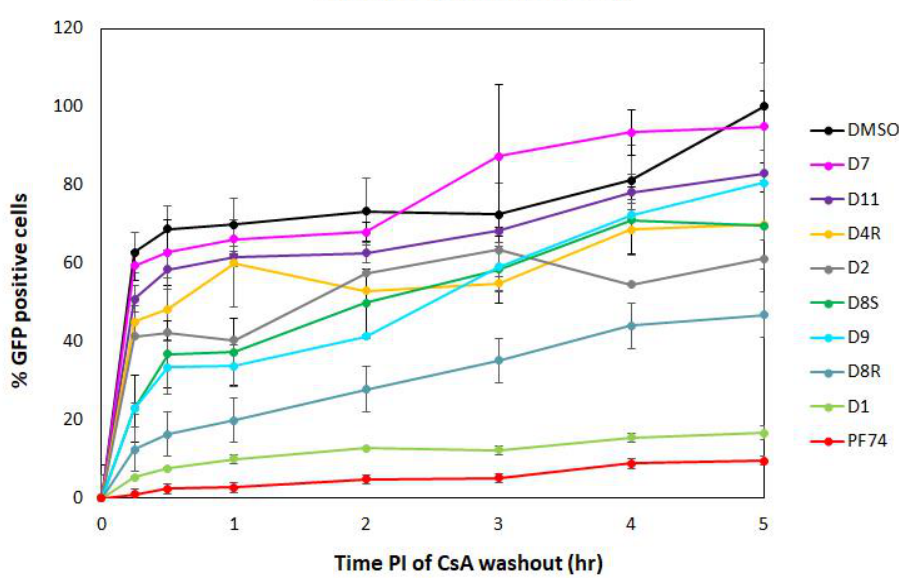
Figure 4. CsA-washout assay. Owl monkey kidney (OMK) cells were infected by spinoculation with an ELISA-normalized amount of VSV-G pseudotyped HIV-1 in the presence of CsA and DMSO, PF74 and its derivatives. Inhibitors were added to the HIV-1 sample before spinoculation at a final concentration of 10 µ M. At the indicated times post-infection, the CsA-containing medium was replaced with fresh, CsA-free culture medium. The percentage of GFP-positive OMK cells was determined by flow cytometry using a BD FACS Aria III (Becton Dickinson) flow cytometer and the data were analyzed with Diva 8 software. The number of GFP-positive cells measured at the indicated time was then calculated and normalized to the DMSO-containing non-drug control reaction, which was considered as 100%.